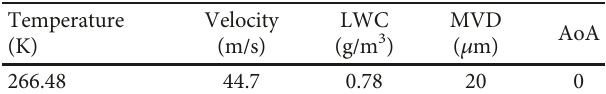
Table 1: Environment conditions of NASA